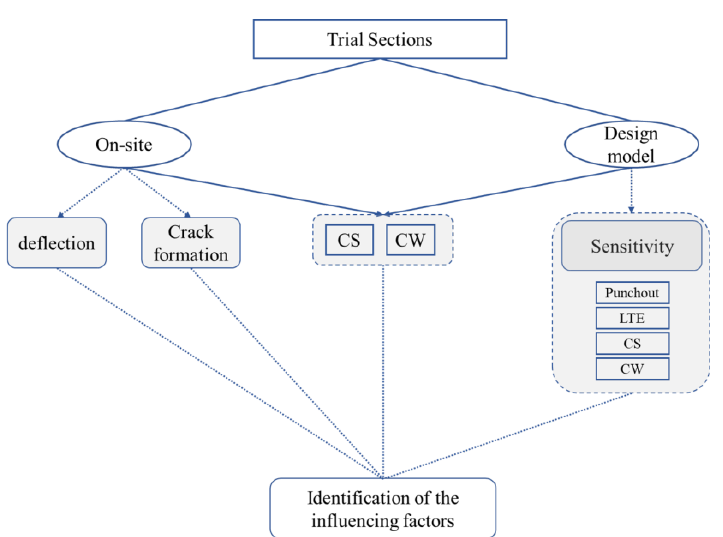
Figure 2. Methodology to identify the influencing factors that are not embedded in the design pro- cedure [CS: crack spacing; CW: crack